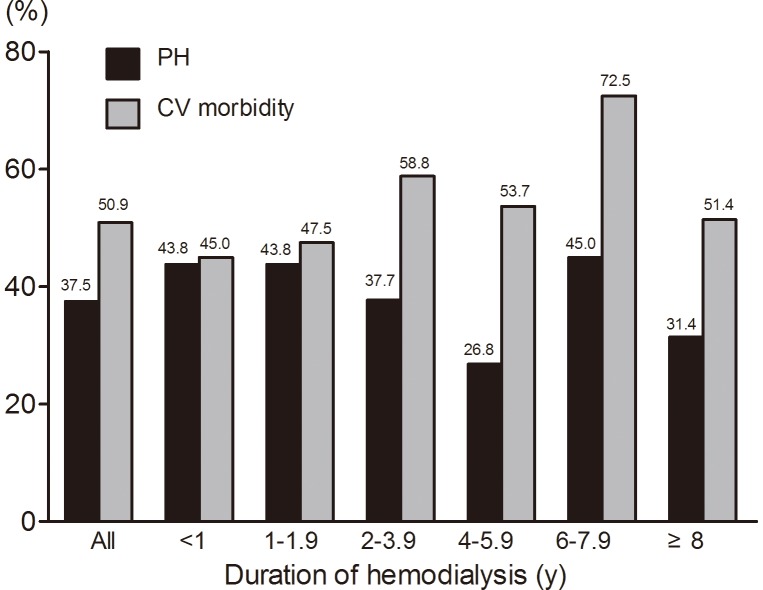
Prevalence of PH and CV morbidity stratified by duration of hemodialysis.Prevalence of neither PH nor CV morbidity showed increasing trend.